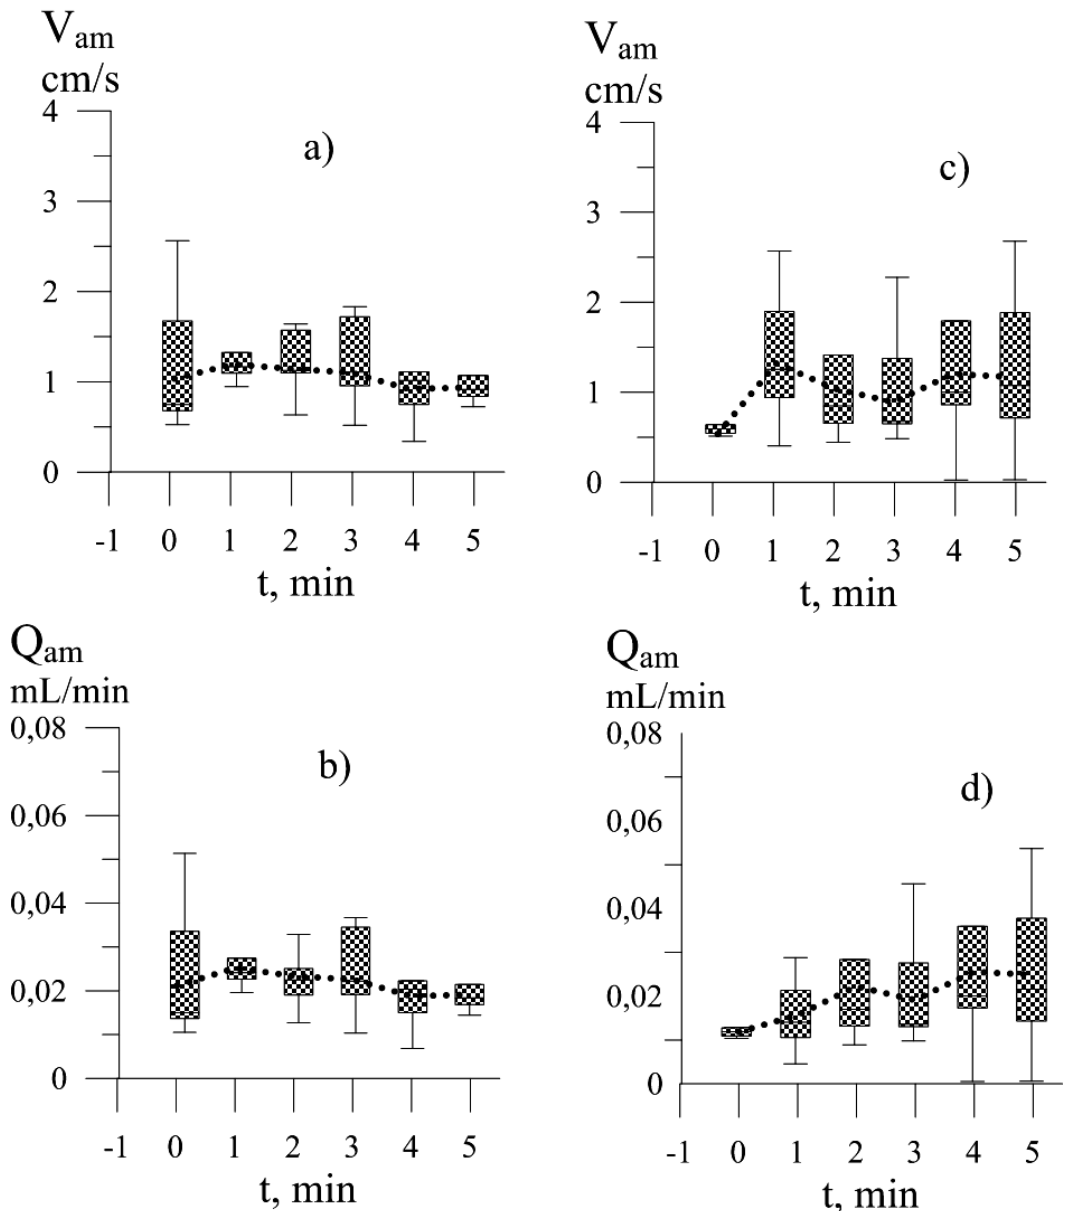
Figure 3. The values of linear (b, d ) and volumetric ( a, c ) blood flow velocities in the simulation in the MathCad program: a, c - the left hand; b, d - right